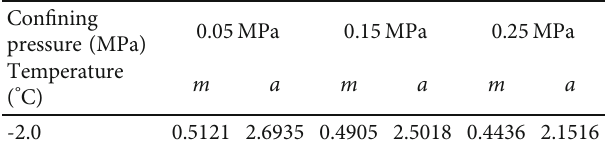
Table 7: Shape parameter and scale parameter solutions (method 1).